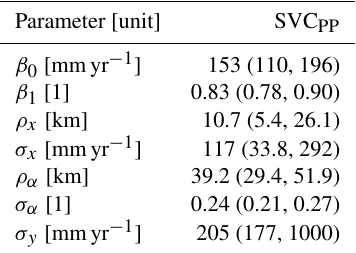
Table 1. Posterior median (0.025 quantile, 0.975 quantile) for the parameters of the SVC PP